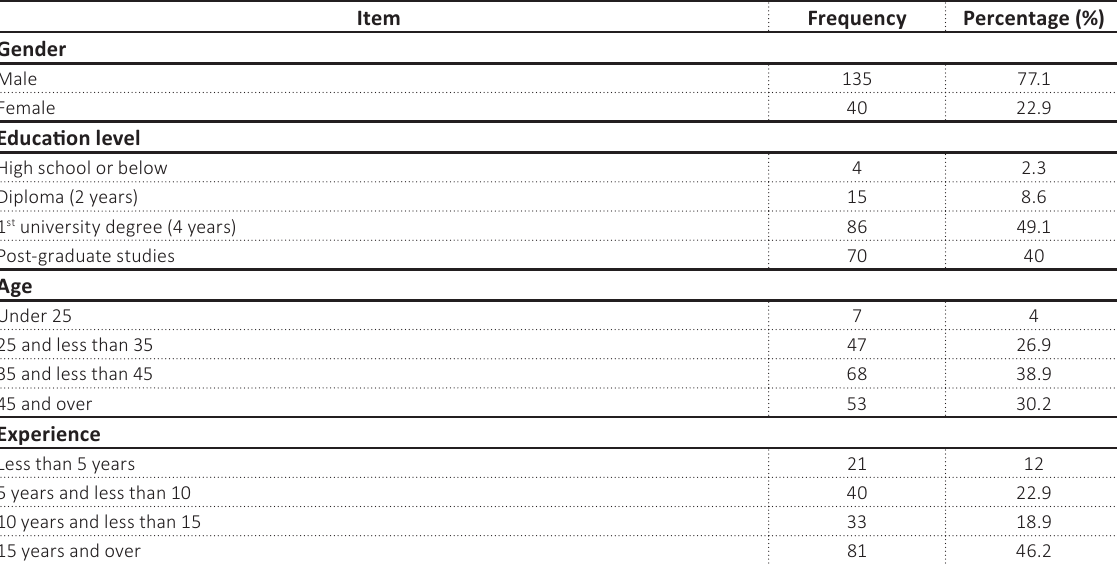
Table 1. Descriptive statistics of